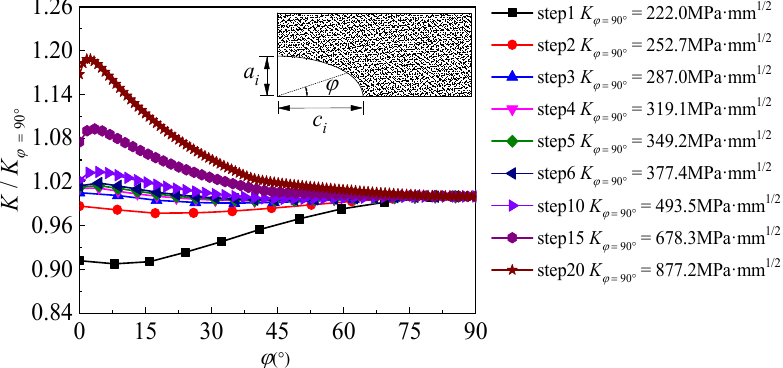
Figure 11. Distribution characteristics of SIF along the crack front of the semi-elliptical surface crack of specimen C9-DS1-A during partial-through crack propagation stage.